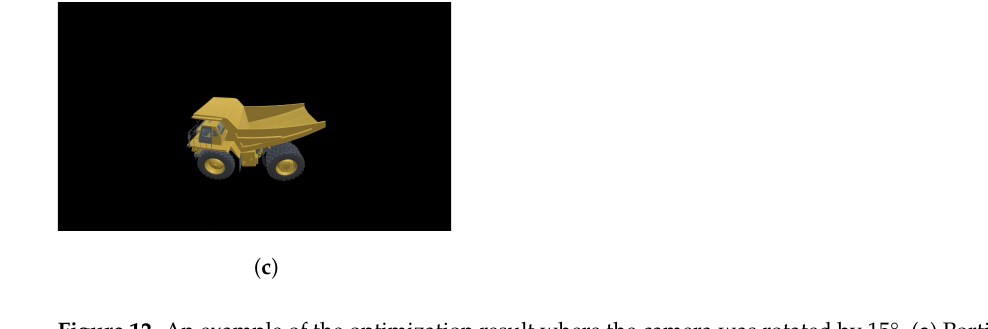
Figure 12. An example of the optimization result where the camera was rotated by 15°. ( a ) Portion of the input equirectangular image taken by the 360° camera. ( b ) Result of the segmentation. ( c ) Opti- mization result in which the CAD is rendered in the final pose found by the optimization algorithm.